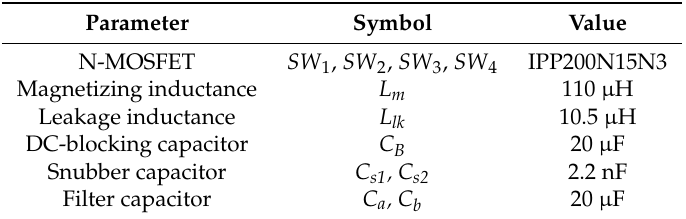
Figure 12. Photographs of ( a ) the proposed and ( b ) conventional CBB BDCs. Table 3. Circuit parameters of the proposed converter.